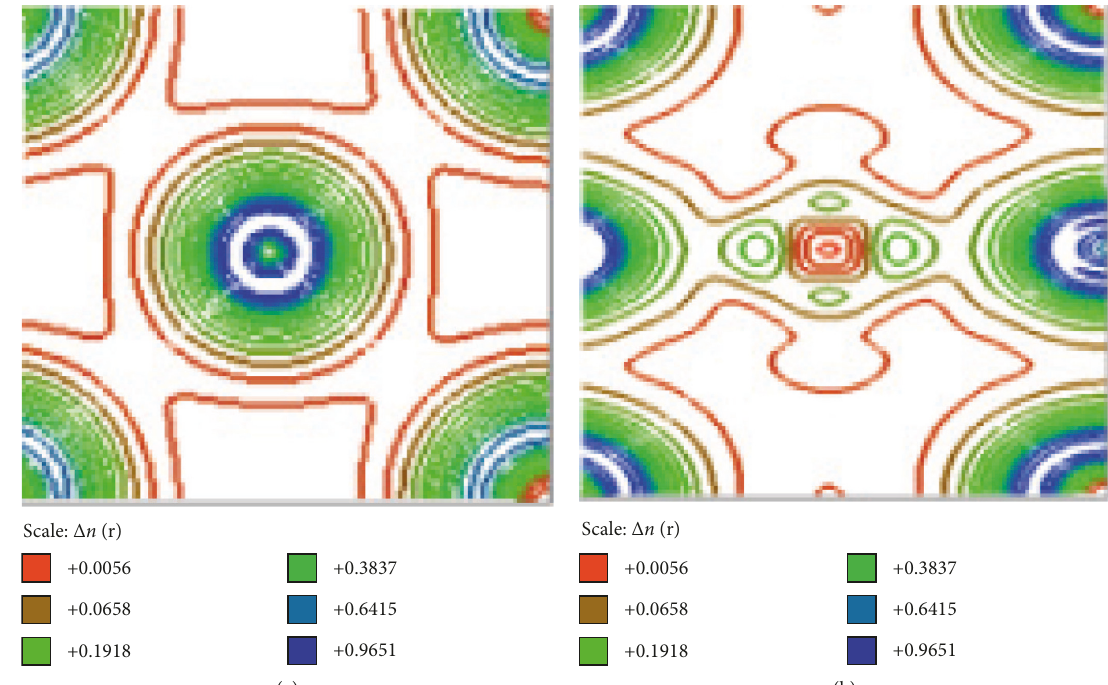
Figure 7: Electronic charge density in 100 and 110 plane of PbTiO